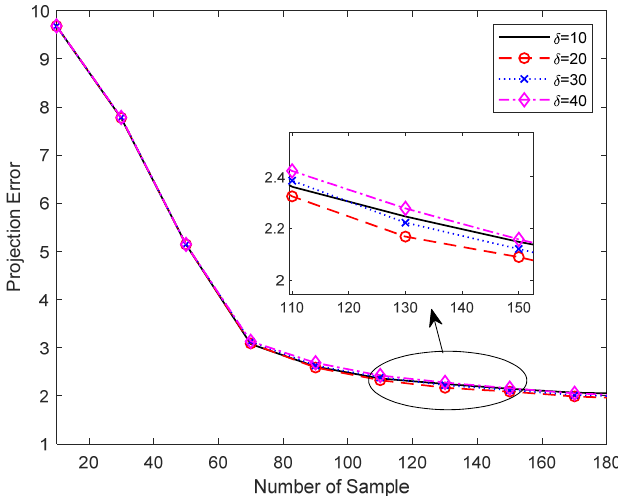
Figure 2. Projection error versus training samples: with different δ .